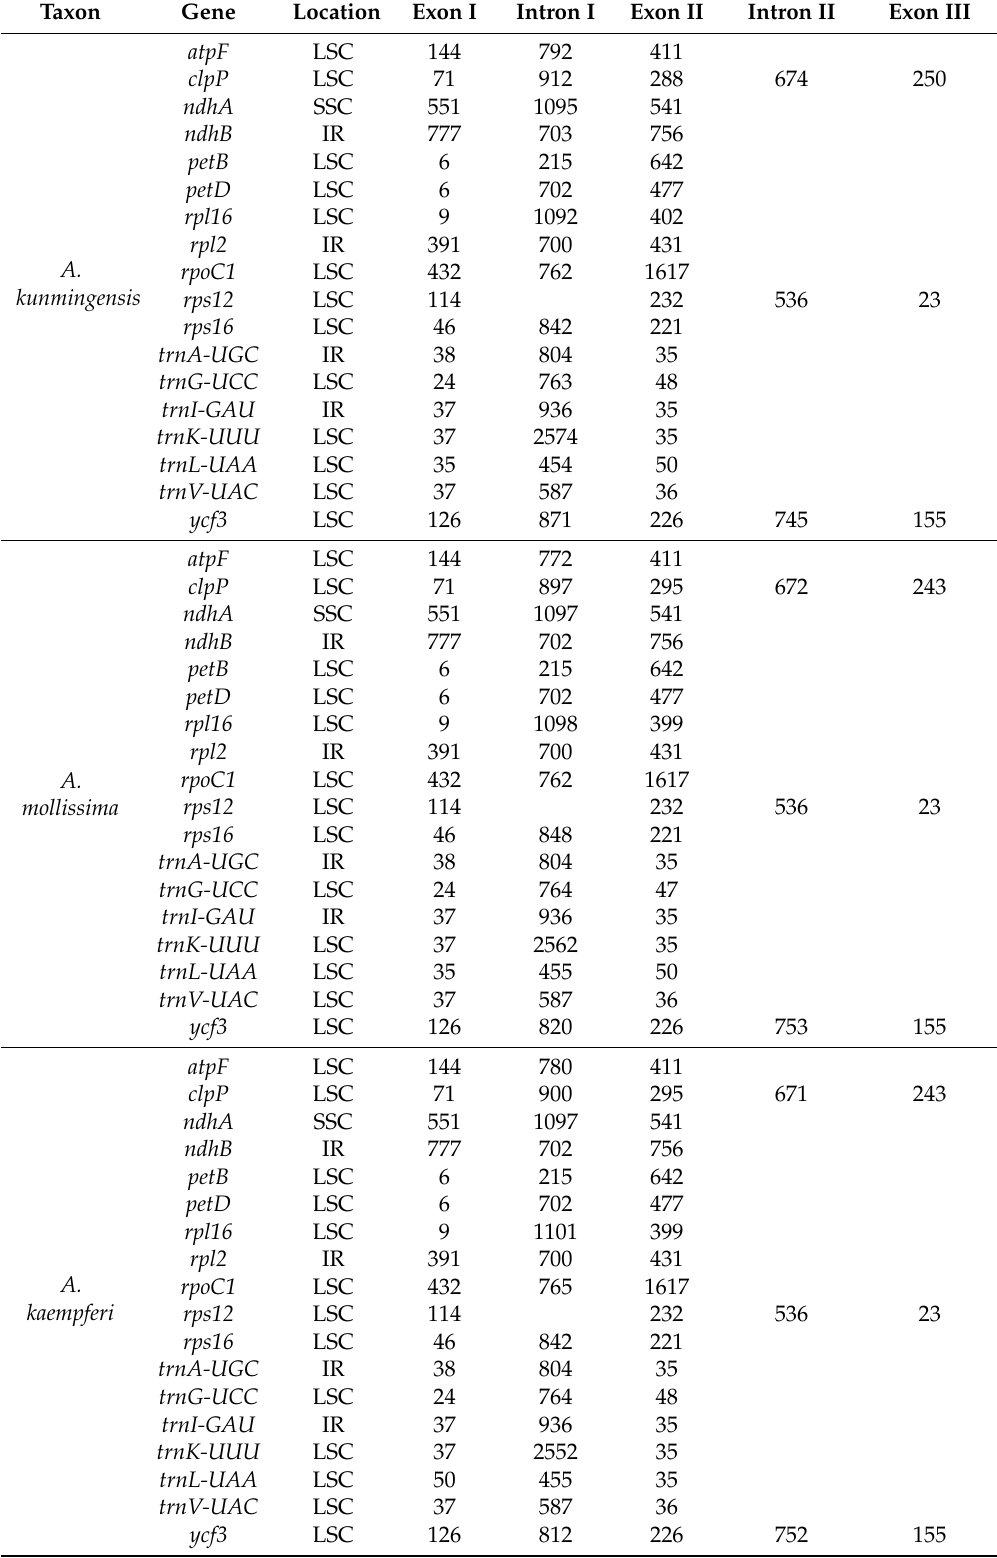
Table 3. Genes with introns in the seven cp genomes of Aristolochia as well as the lengths of the exons and